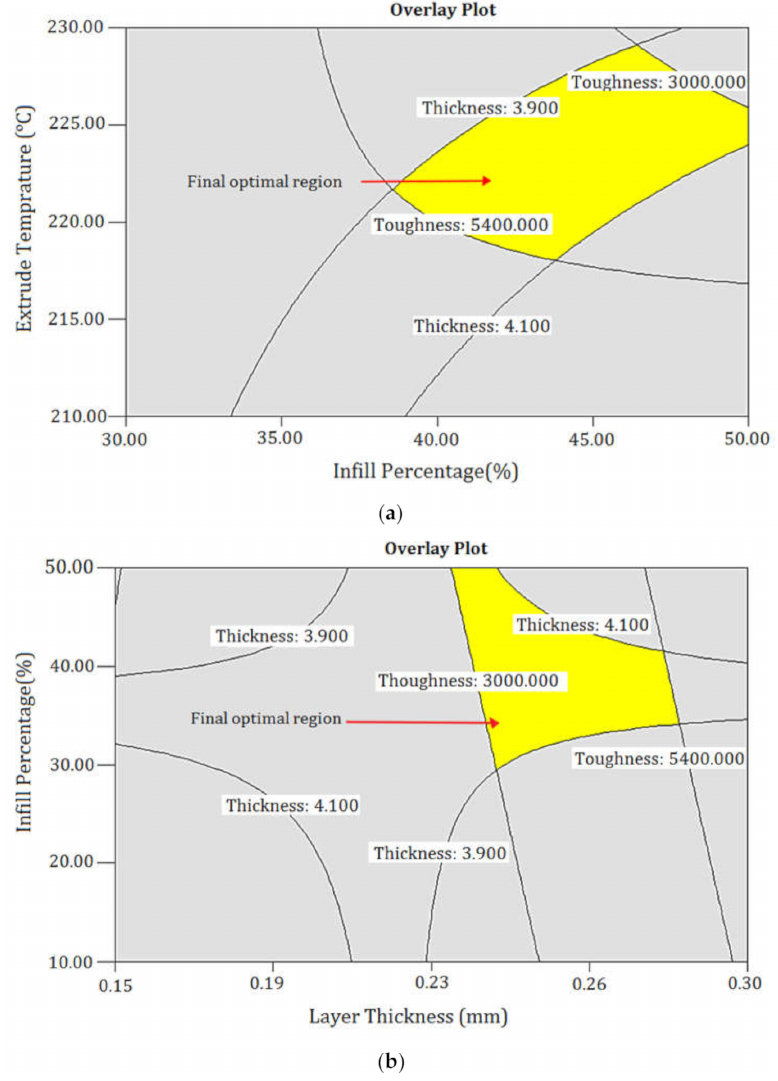
Figure 15. Overlaying contour maps in terms of ( a ) ET and IP and ( b ) IP and